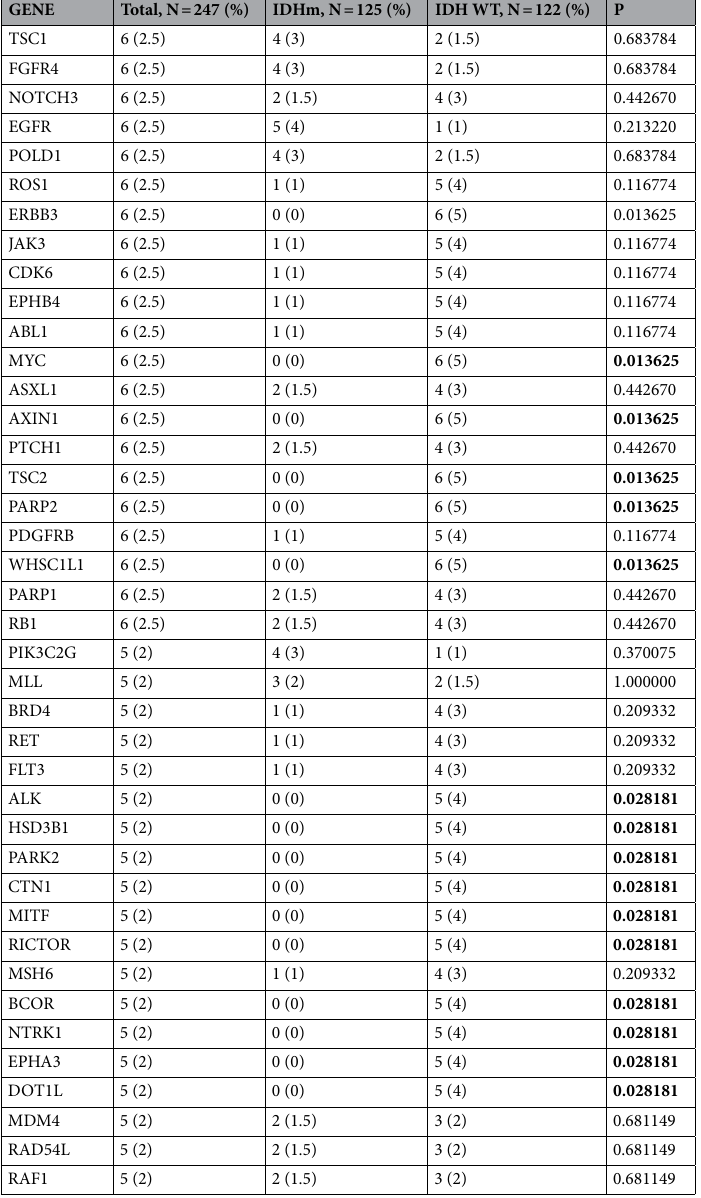
Table 2. Genomic alterations in whole sample and according to the IDH1 status. Significant values are in